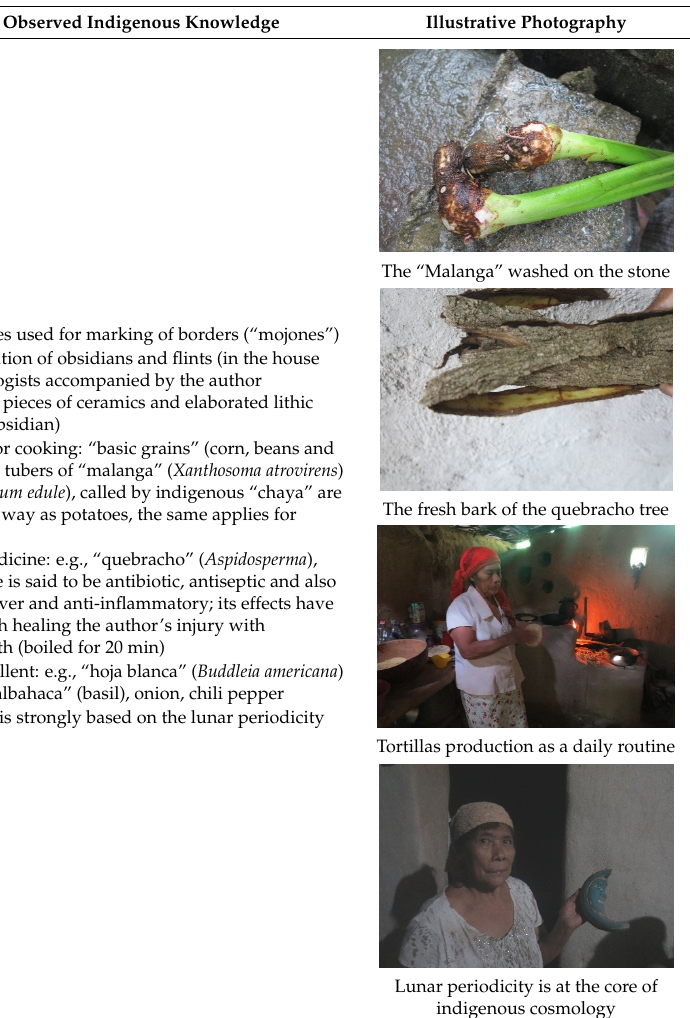
Table 2. Indicated knowledge and meanings, methods applied and research localities.